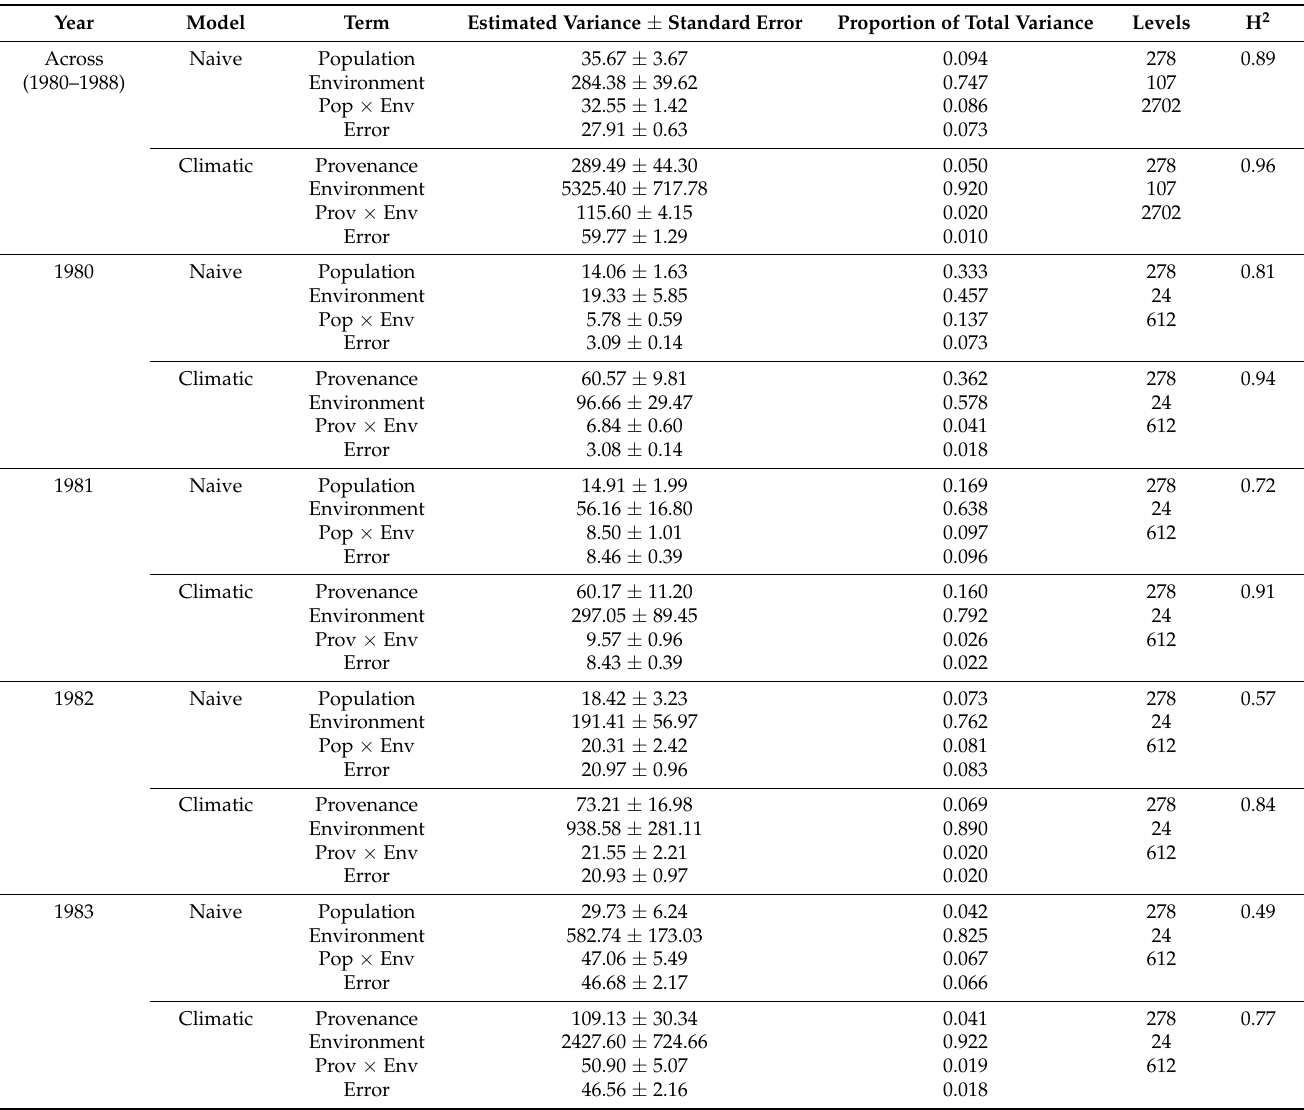
In the naïve within-year analysis (Model (5)), the environmental variance increased while the broad-sense heritability and population variance tended to decrease over time from 1980 (seven-year-old trees, H 2 = 0.81, genetic variance = 33%, environmental variance = 46%) to 1983 (10-year-old trees, H 2 = 0.49, genetic variance = 4%, environmental variance = 83%) (Table 1). In contrast, specifying the variance-covariance of the population and environment terms with climatic similarity matrices (“climatic” Model (6)) led to more stable estimates of broad-sense heritability (H 2 1980 → 1983 = 0.94 → 0.77) and population × environment variance (population × environment variance 1980 → 1983 = 4 → 2%) over time (Table 1). Within-year climatic modeling (6) demonstrated an increase in environmental variance and a decrease in population variance over time (genetic variance 1980 → 1983 = 36 → 4%, environmental variance 1980 → 1983 = 58 → 92%) similar to that of the naïve models (Table 1). Table 1. Broad-sense heritability (H 2 ) and number of levels and estimated variances for pop- ulation/provenance, environment, and residual random effects from tree height models across (1980–1988) and within (1980–1983) years. Term Estimated Variance ± Standard Error Proportion of Total Variance Levels H